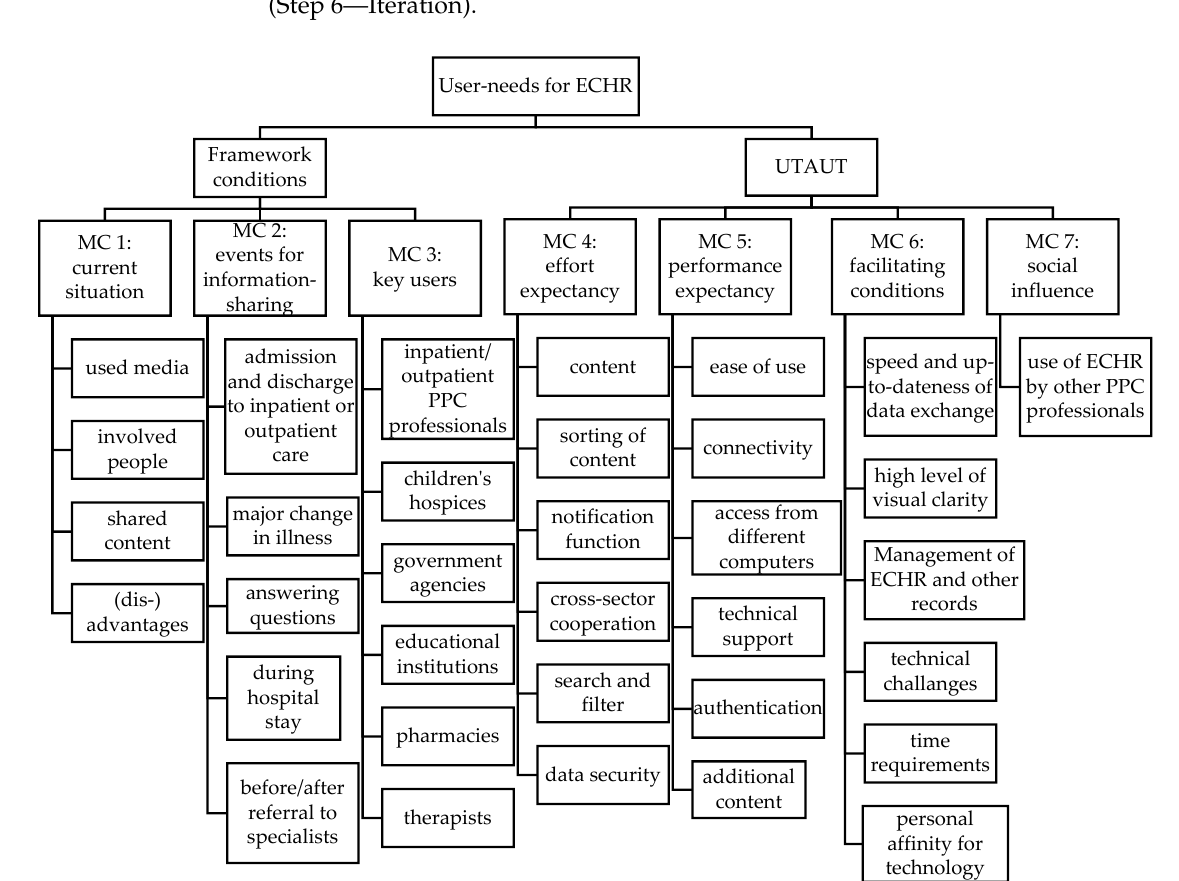
Figure 1. Extract from the category system.